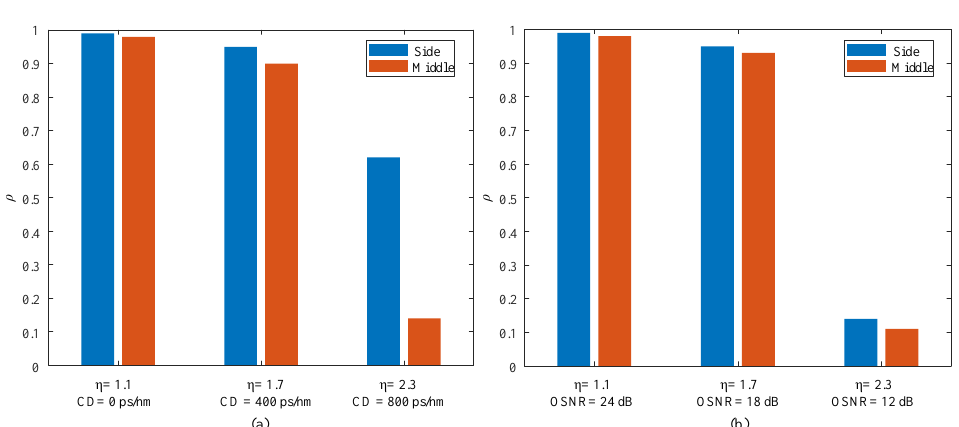
Figure 9. Monitoring scenarios for different impairments.